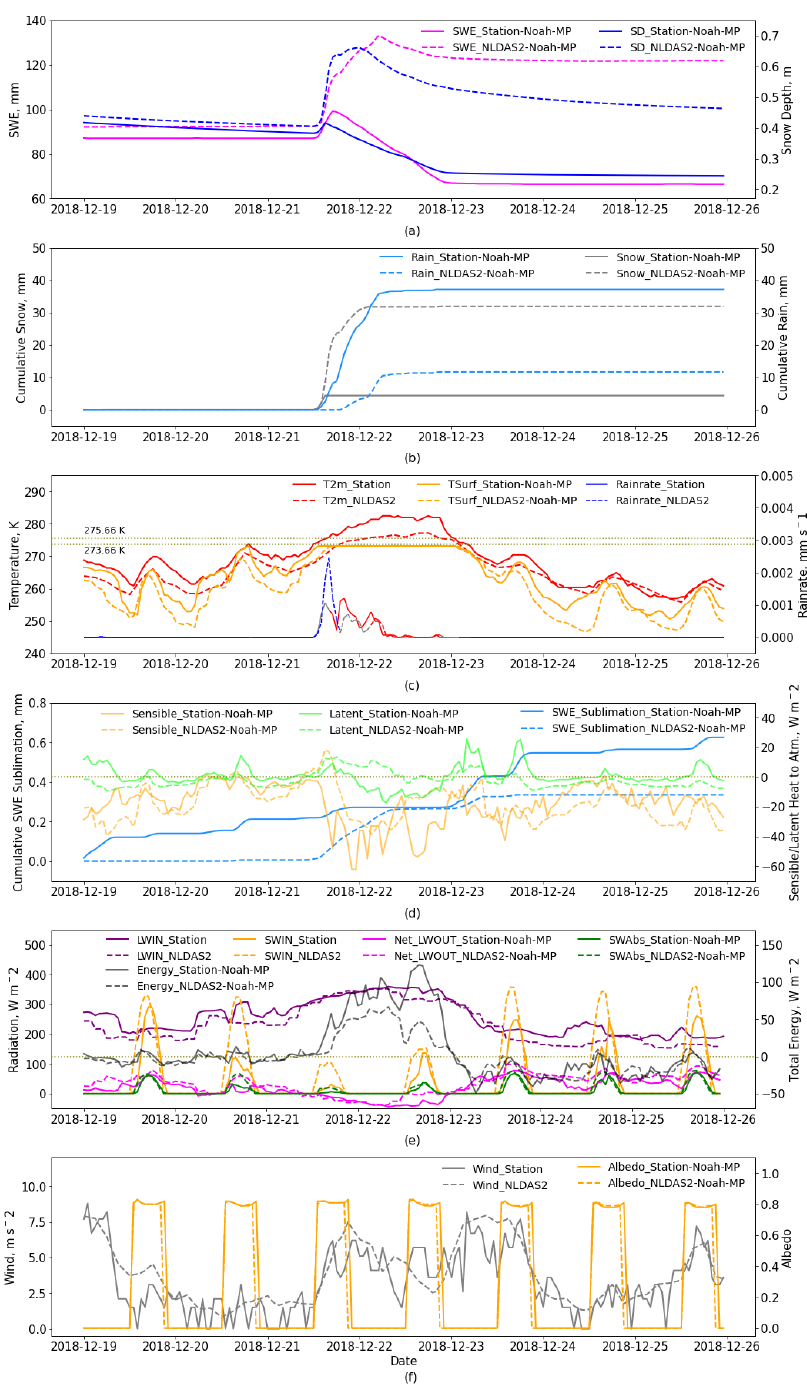
Figure 6. ( a ) Snow Water Equivalent and Snow Depth; ( b ) Cumulative Snow and Rain; ( c ) 2 m air Temperature, Surface Radiative Temperature (TRAD), and Rain-rate (the blue color indicates snowfall, gray color indicates mixed precipitation, and red color indicates rain); ( d ) Sensible and Latent Heat to the Atmosphere and Cumulative Snow/Ice Sublimation; ( e ) Incoming Longwave and Shortwave Radiation, Absorbed Shortwave Radiation, Total Net Outgoing Longwave Radiation, and Total Energy; and ( f ) Surface Albedo and Wind Speed, from 19 − 25 December 2018. The precipitation event on 27 November brought rain and snow that increased SWE and SD in both simulations, with a greater increase in NLDAS2-Noah-MP compared to the Station-Noah-MP simulation (Figure 5a,c). Right before 28 November, SWE started